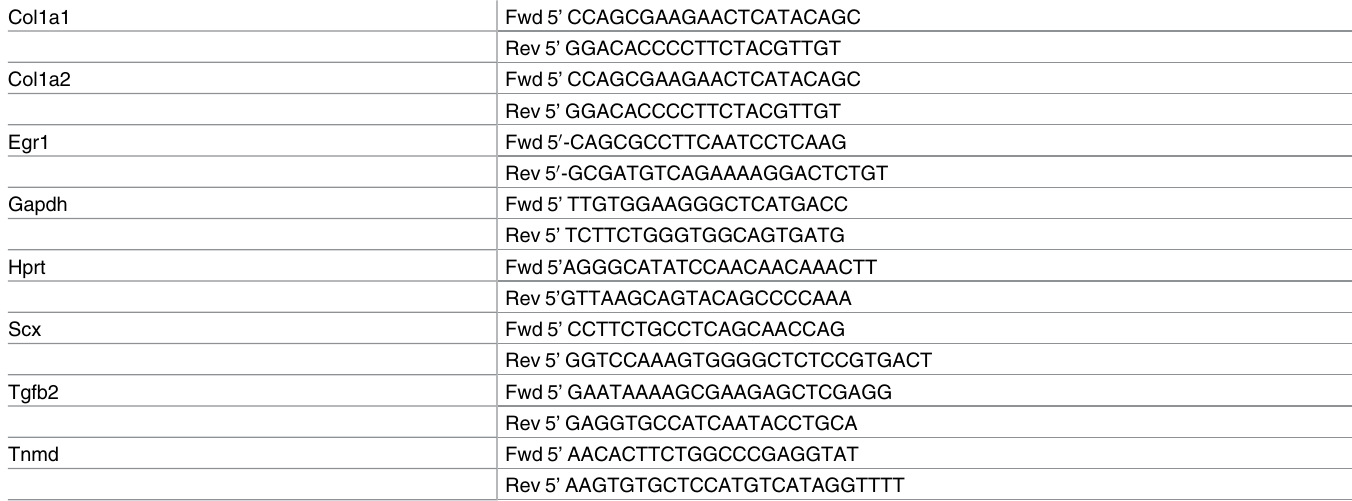
Table 1. Primers used for quantitative